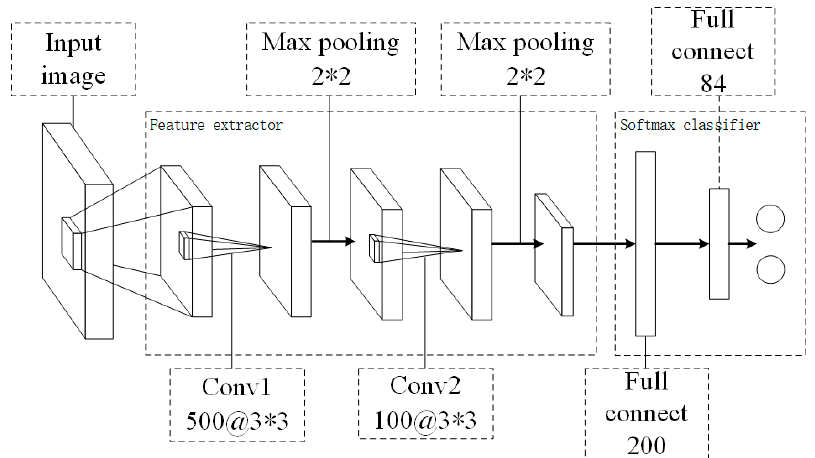
Figure 3. The convolutional neural network structure for building extraction.